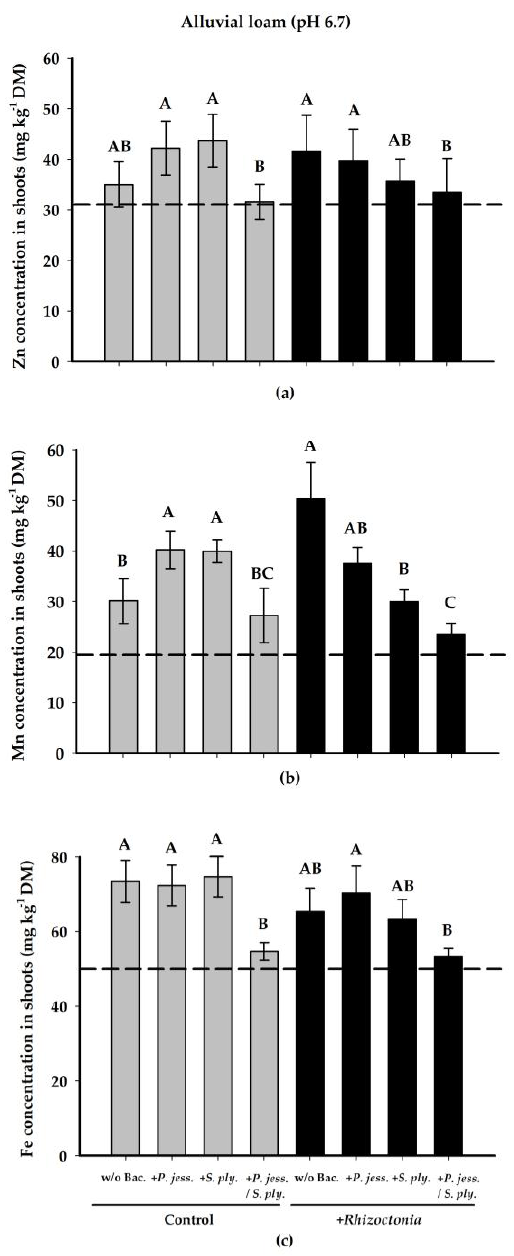
Figure 4. Micronutrient concentrations of Zn ( a ) Mn ( b ) and Fe ( c ) in shoots (mg kg −1 DM) of Lactuca sativa L. cv. Tizian. The plants were grown on alluvial loam without bacterial inoculation (w/o Bac.), pre-inoculated with Pseudomonas jessenii RU47 ( +P. jess. ), Serratia plymuthica 3Re-4-18 ( +S. ply. ), a combination of both ( +P. jess / S. ply. ), with and without (Control) subsequent inoculation with Rhizoctonia solani AG1-IB (+ Rhizoctonia ). Means ± standard errors of four independent replicates. The dotted lines indicate the threshold levels for micronutrient deficiency. Different characters indicate significant differences (one-way ANOVA, Holm-Sidak test, p =